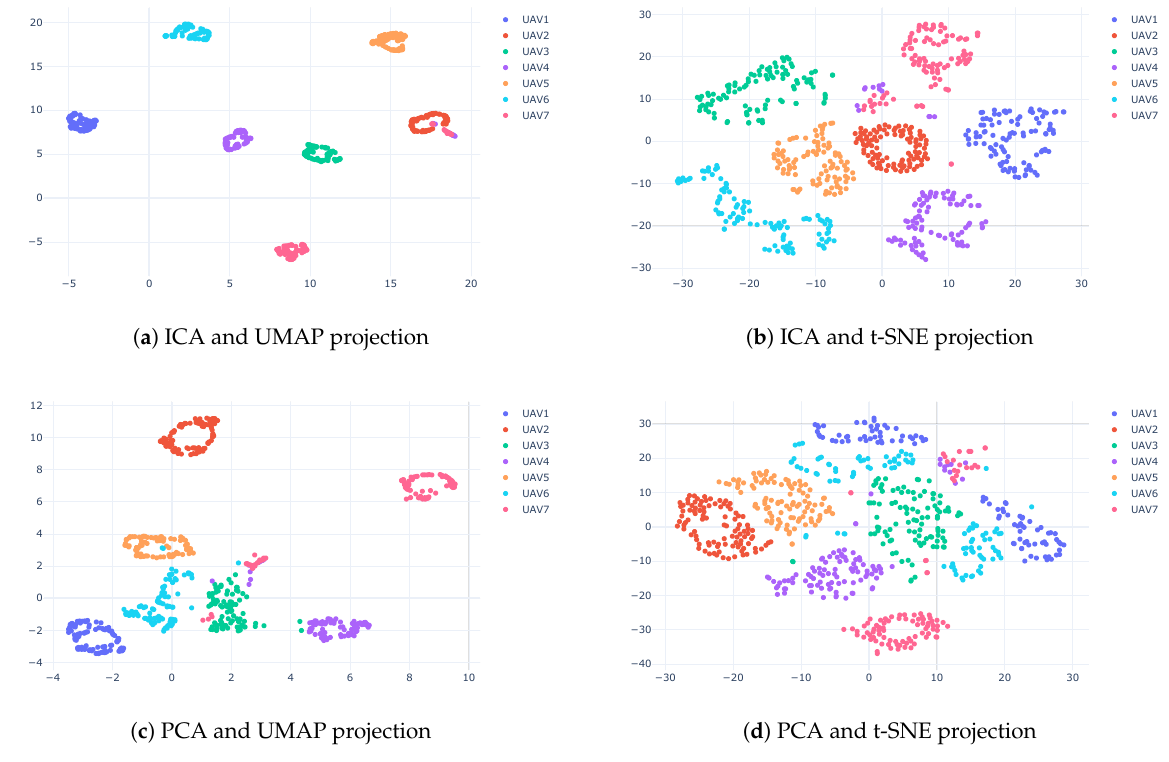
Figure 18. Clustering results using linear and nonlinear techniques for WST features.